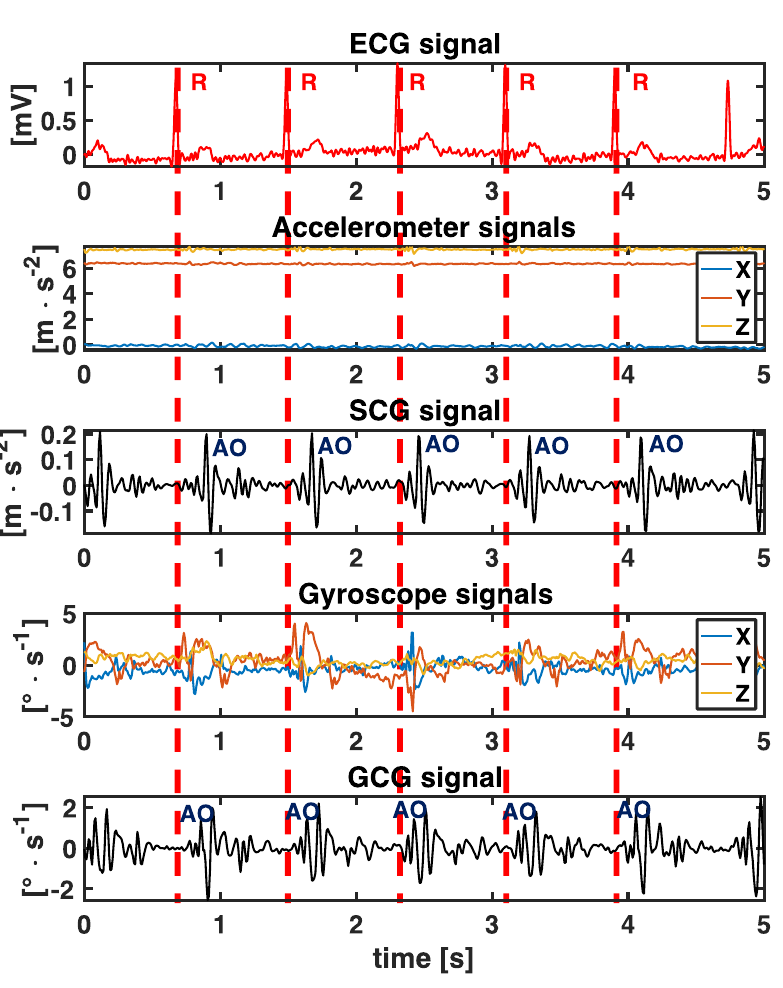
Figure 2. 5 s of collected data from a volunteer in a lying position. First subplot: ECG waveform with detected R peaks. The R-R peaks distance allows calculating IBI RR , i . Second subplot: raw accelerations along the x -, y -, and z -axes. Third subplot: the obtained SCG signal with detected AO peaks. The AO-AO peaks distance allows calculating IBI AOAO , i . Fourth subplot: raw angular velocities along the x -, y -, and z -axes. Fifth subplot: the obtained GCG signal with detected AO peaks. The AO-AO peaks distance allow calculating IBI AOAO , i